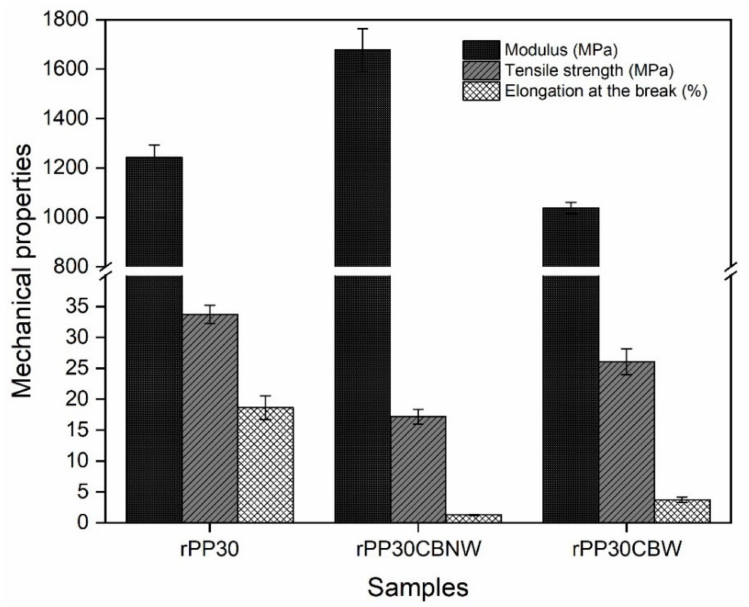
Figure 8. Mechanical properties of the rPP30 and the obtained rPP30 composited with and without the plasticizer